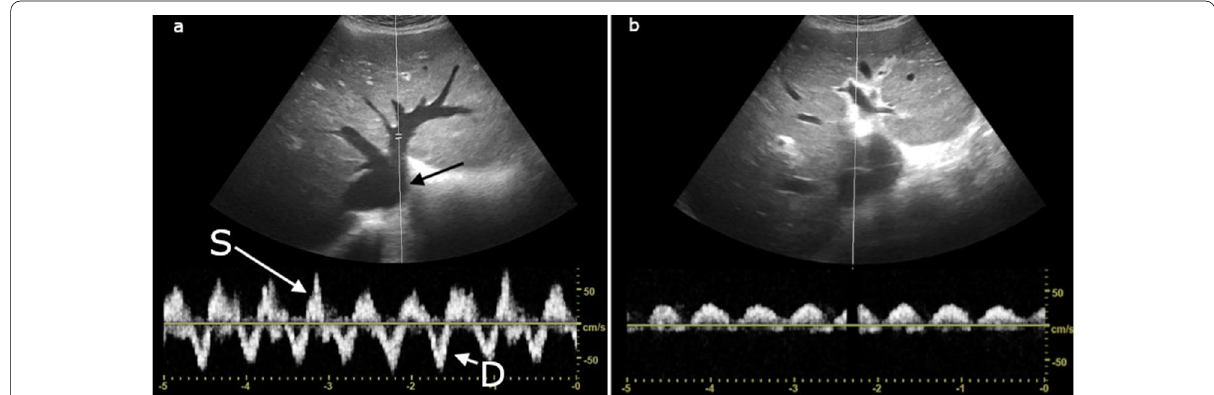
Fig. 2 Case 1: a IVC short axis view (black arrow) and hepatic vein Doppler showing the D wave (short white arrow) and reversal of the S wave (long white arrow). b Portal vein Doppler showing > 100% pulsatility with some flow